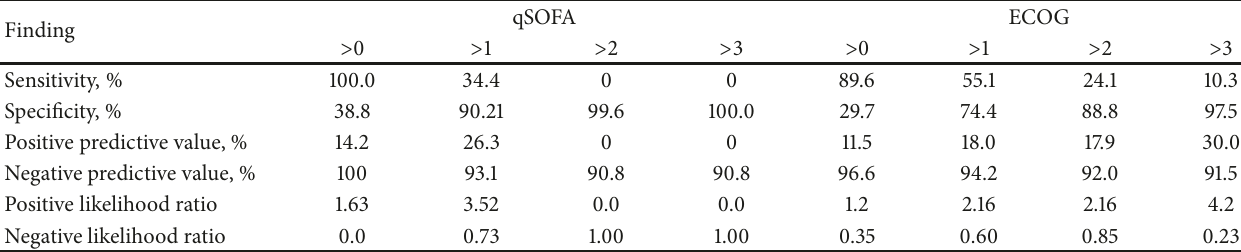
Table 2: Sensitivity, specificity, positive predictive value, negative predictive value, positive likelihood ratio, and negative likelihood ratio for quick sequential organ failure assessment (qSOFA) and Eastern Cooperative Oncologic Group (ECOG) for in-hospital